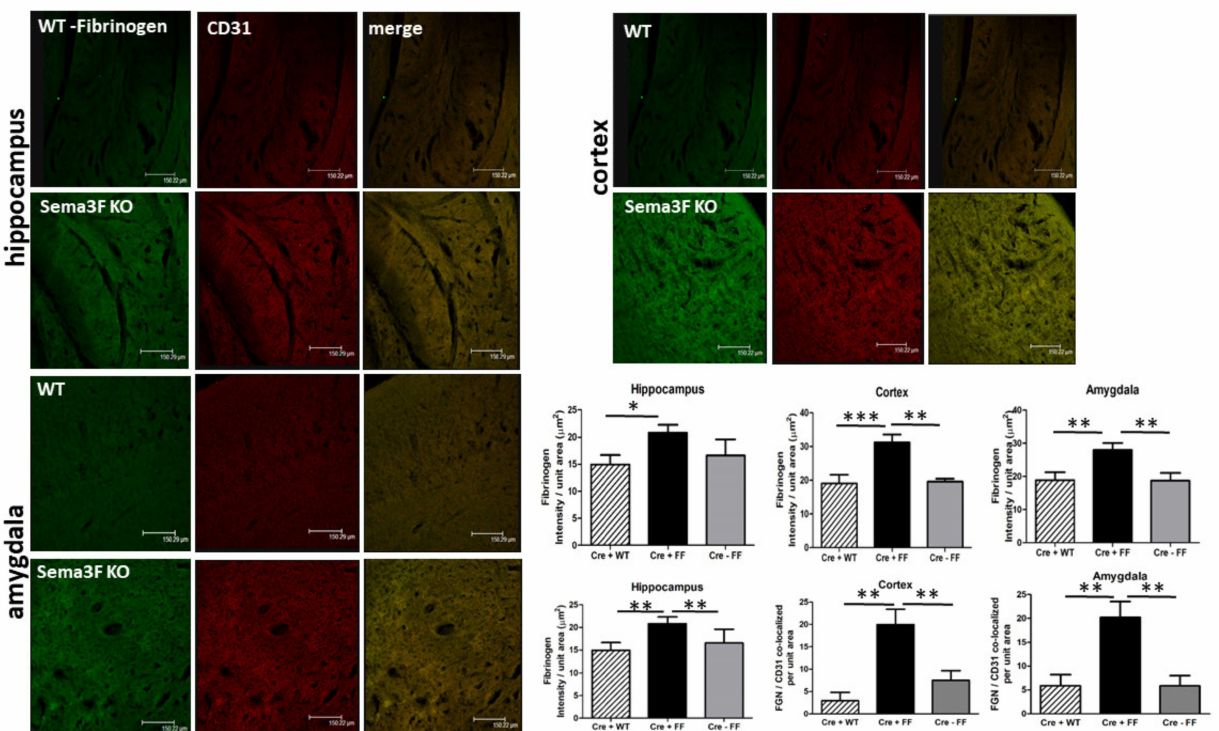
Figure 11. Expression of Fibrinogen and PECAM-1 in Sema 3F KO Mice . Immunofluorescent staining of fibrinogen (green) and PECAM 1 (CD31; red) in the hippocampus ( upper left ), cortex ( upper right ) and amygdala ( lower left ) of Sema 3F KO mice and their wild type (WT) littermate showed significantly increased fibrinogen (green) accumulation, co-localizing with CD31 (red) in Sema 3F KO tissue, suggesting vascular inflammation. Quantification of fibrinogen immunofluo- rescence (upper part of the lower right panel) showed significantly higher fluorescence/unit area in the hippocampus, cortex, and amygdala of Sema 3F KO mice compared to the two control mice. *** p ≤ 0.0001; ** p ≤ 0.001; * p ≤ 0.01; n = 3. Quantification of fibrinogen-CD31 co-localization (bottom part of the lower right panel) showed increased co-localization in the hippocampus, cortex, and amygdala of Sema 3F KO mice compared to the two control mice. ** p ≤ 0.001; n =